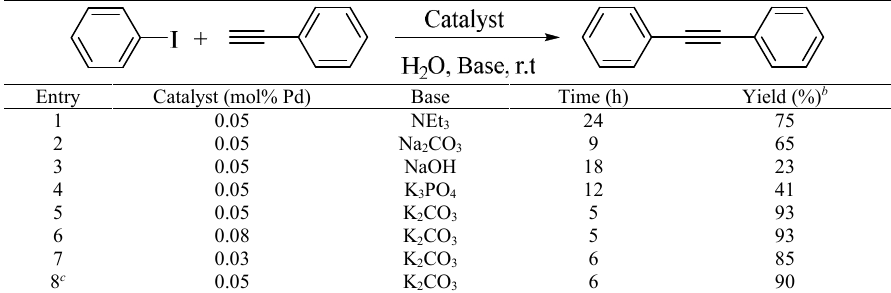
Table 5. Optimization of the conditions in the sonogashira reaction of iodbenzene with phenylacetylene catalyzed by MNP/HPG-CA/Pd a